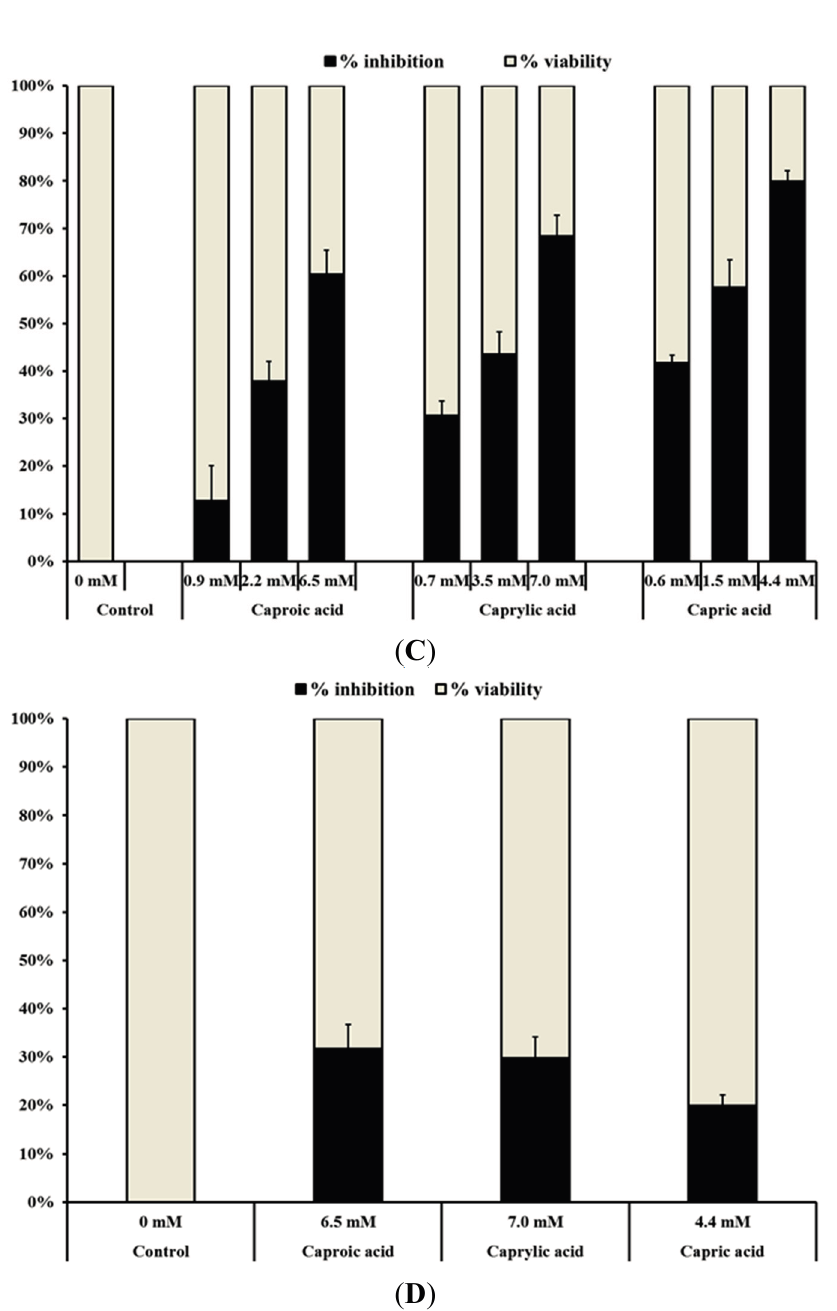
Figure 1. Inhibitory effect of goat milk medium chain fatty acids on the growth of ( A ) human colorectal carcinoma cells; ( B ) human skin epidermoid carcinoma cells; ( C ) human mammary gland adenocarcinoma cells and ( D ) normal human colon fibroblast cells. Cancerous cells (approximately 10 5 cells/mL) were seeded into 96-well tissue culture plates and incubated at 37 °C for 24 h prior to treatment. After 24 h, fresh growth medium containing the various concentrations of capric (0.60, 1.50 and 4.40 mM), caprylic (0.70, 3.50 and 7.00 mM) or caproic acids (0.90, 2.20 and 6.50 mM) was added into each well. Following incubation at 37 °C for 48 h, the growth inhibitory activity of the fatty acids was investigated using the MTT colorimetric